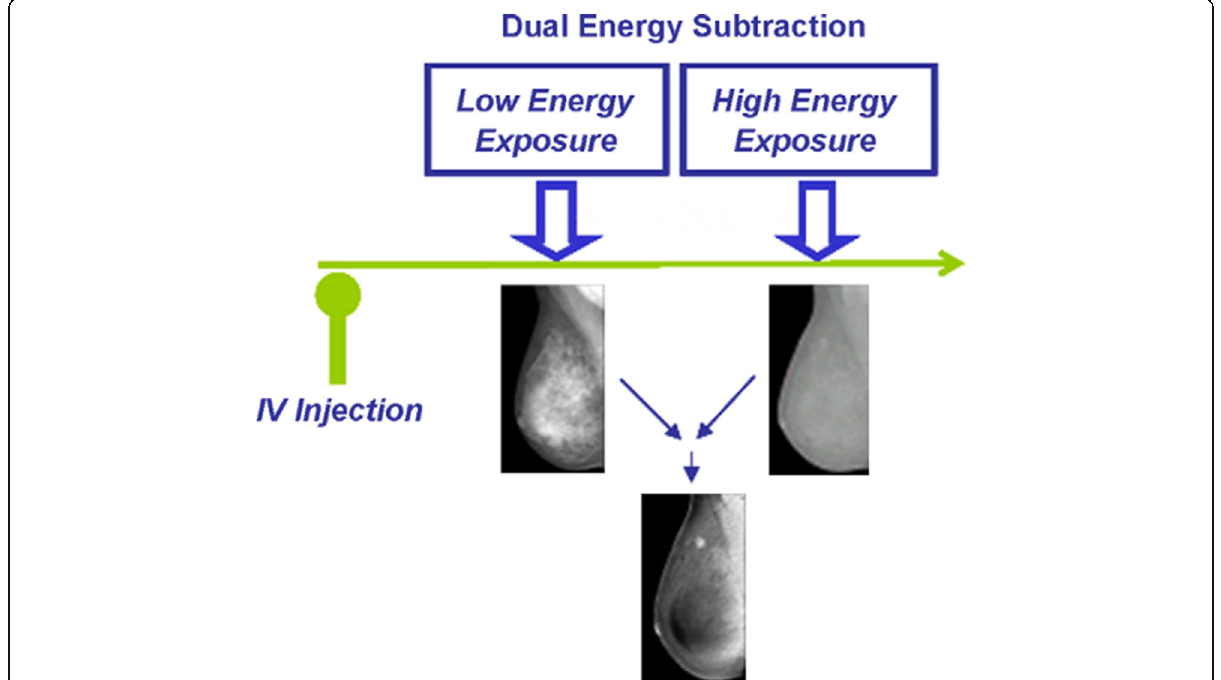
Fig. 5 Contrast-enhanced dual-energy mammography